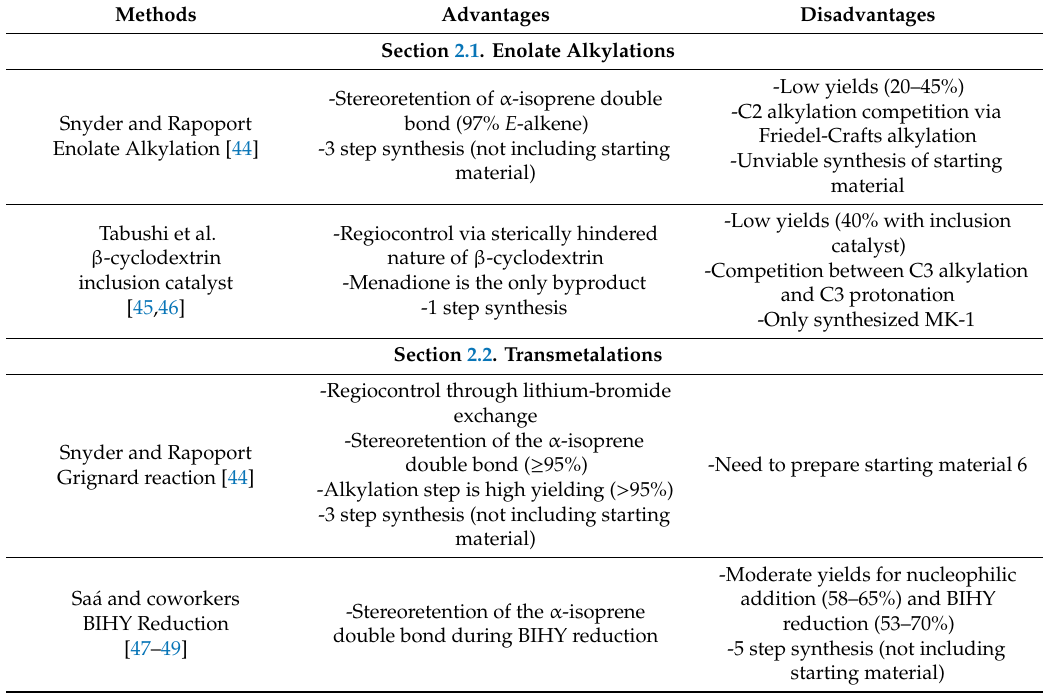
Table 4. Summary of nucleophilic ring methods.